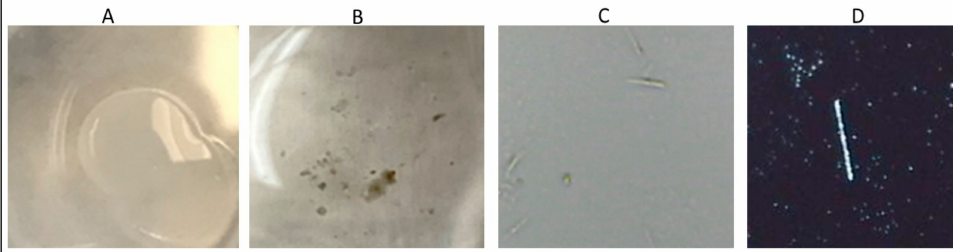
Figure 2. Comparative analysis of clear synovial fluid analysis for detection of urate crystals. Repre- sentative images from one sample (n = 5). ( A ) Control; ( B ) iPhone image; ( C ) Plugable Microscope image; ( D ) Accuscope Microscope image.